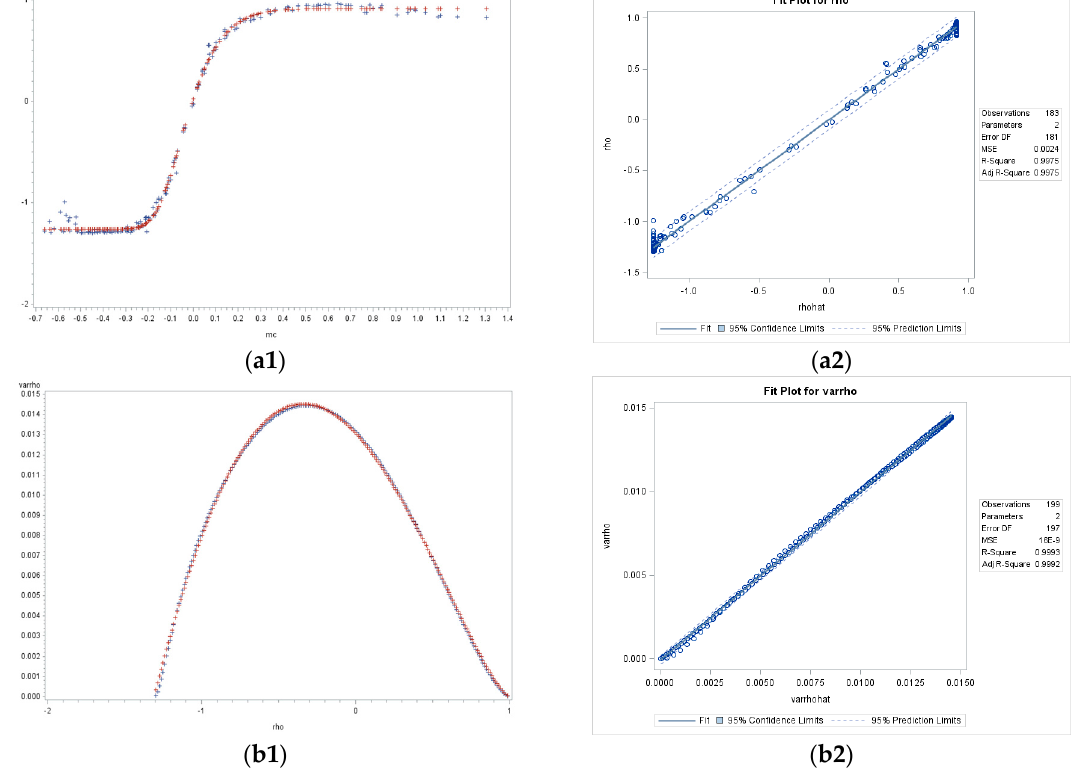
Figure A7. Curve fitting plots and bivariate regression plots for Wuhan census blocks data. ( a1 , a2 ) The original MC-ˆ ρ scatter plot (blue) superimposed on the theoretical MC- ρ curve (red), and a bivariate regression scatter plot for the original and predicted ρ ; ( b1 , b2 ) the original ˆ ρ -var(ˆ ρ ) scatter plot (blue) superimposed on the theoretical ˆ ρ -var( ˆ ρ ) curve (red), and a bivariate regression scatter plot for the original and predicted Var(ˆ ρ ).